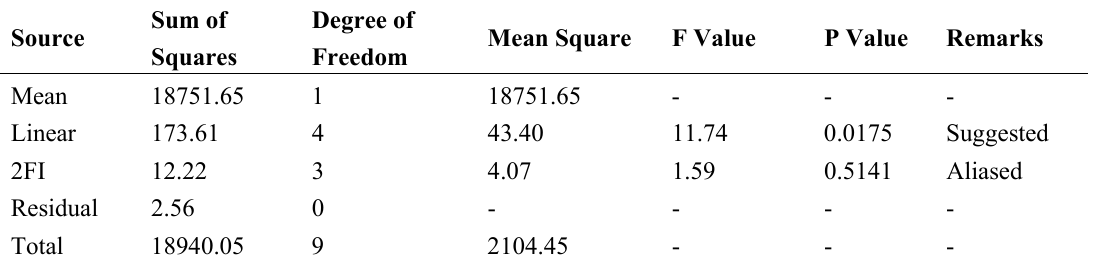
Table 2. Statistical parameters for sequential models.